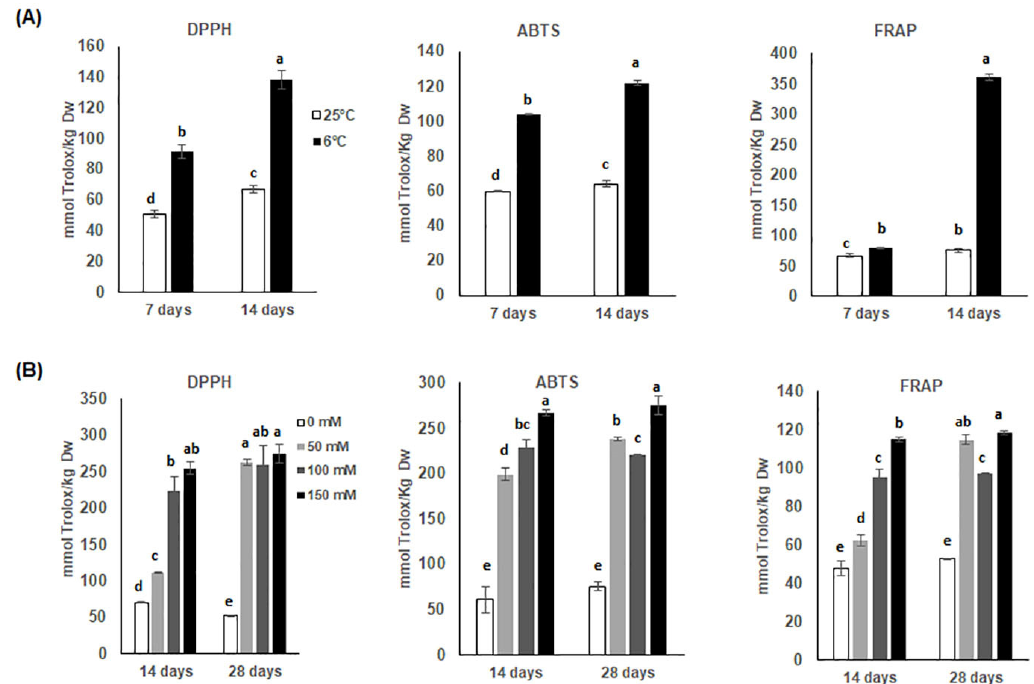
Figure 3. ( A , B ) Changes in antioxidant power measured via 2,2-diphenyl-1-picrylhydrazyl (DPPH), 2,2’-azino-bis 3-ethylbenzothiazoline-6-sulfonic acid (ABTS), and ferric reducing antioxidant power (FRAP) assays in cardoon callus cultures in response to ( A ) 7–14 days chilling at 6 °C or ( B ) 14–28 days of 0, 50, 100, or 150 mM NaCl stress. Values are expressed as TEAC (Trolox ® -equivalent anti- oxidant capacity, mmol Trolox Kg − 1 DW). Each value represents the mean of three biological and two technical replicates ± SD. Statistical significance for each activity between treatments within each time point was determined by using one-way ANOVA with Tukey’s post hoc test. Different letters indicate significant difference (p- value < 0.05).